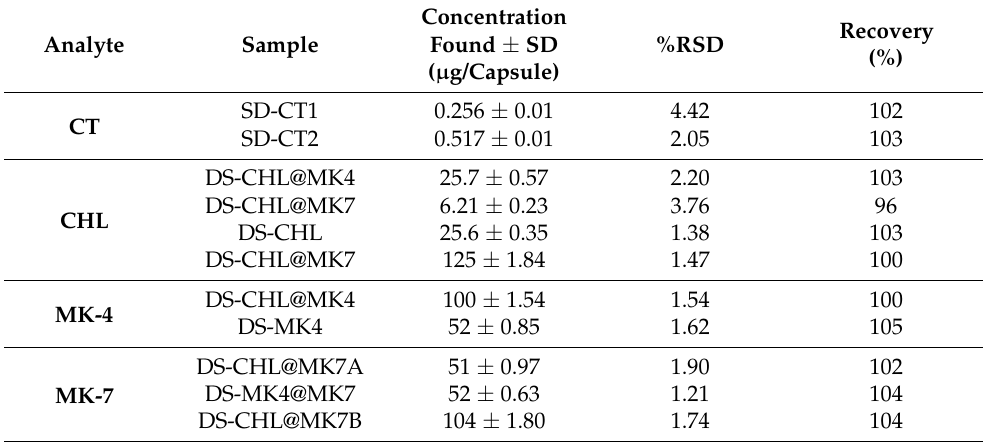
Table 8. Assay results of vitamins D3 and K2 by HPLC in commercial dietary